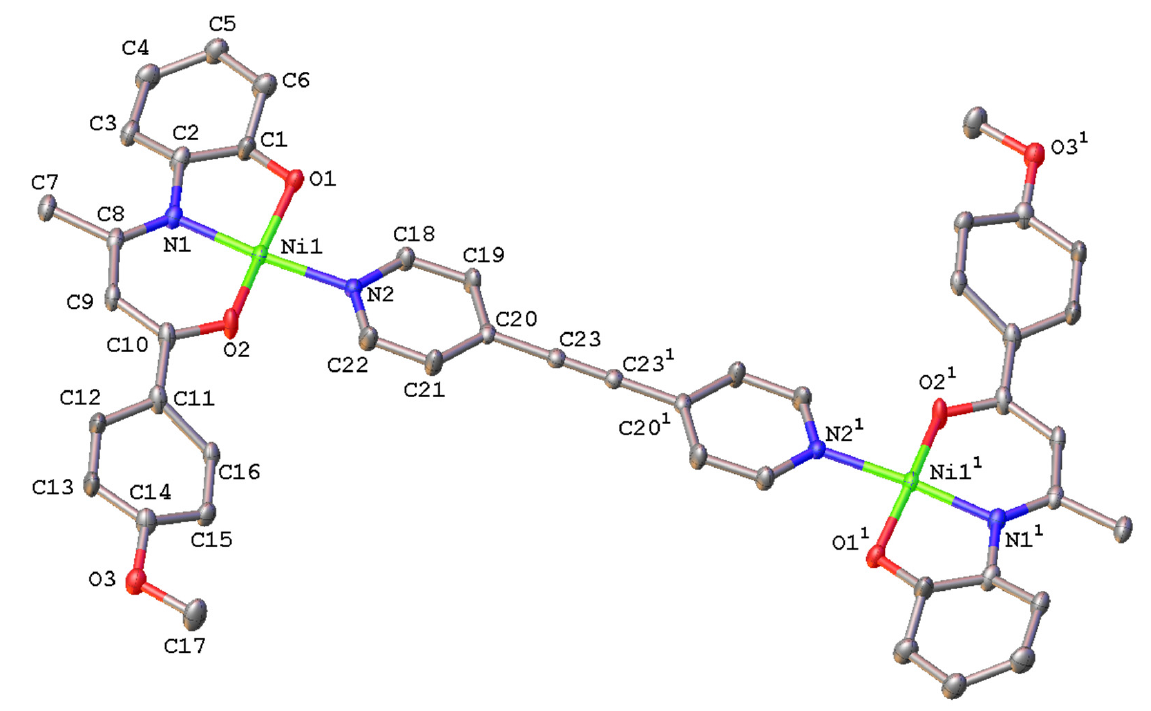
Figure 3. Molecular structure of complex 8 (molecule A )with labelling scheme for selected atoms. Hydrogens have been omitted for clarity. Thermal ellipsoids are drawn at the 40% probability level. Half unit of molecule was generated by symmetry operations -x, -y, -z. Table 1. Selected bond distances (Å) and angles ( ◦ ) for compounds 4 – 8 . Upper value: X-ray; lower value (in italics): DFT. Values into brackets are the corresponding computed Wiberg bond indices.